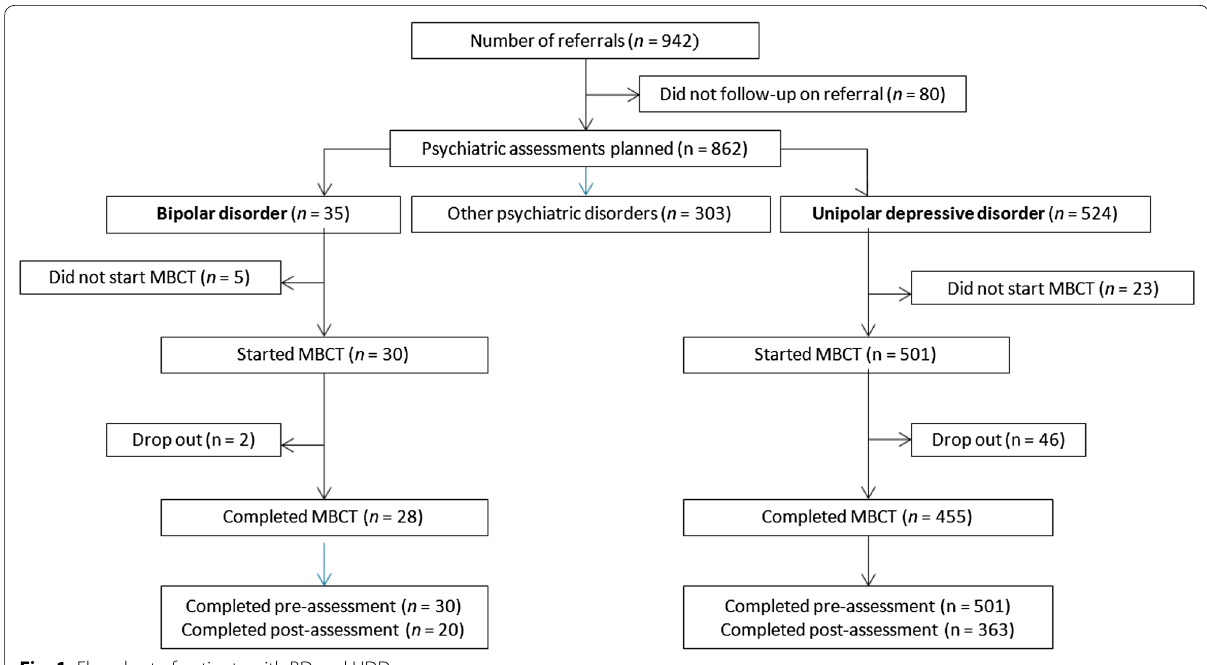
Fig. 1 Flowchart of patients with BD and